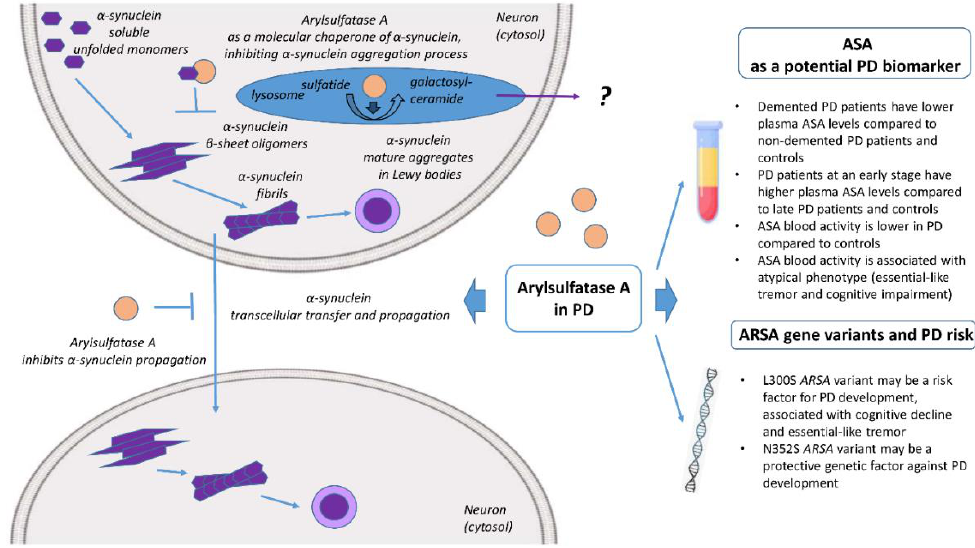
Figure 1. Implication of arylsulfatase A (ASA) in Parkinson’s disease (PD). In vitro and in vivo evidence has demonstrated that ASA may act as a molecular chaperone interacting with α-synuclein (SNCA) in the cytoplasm, thereby preventing its aggregation, secretion, and cell-to-cell propagation. Clinical evidence supports the role of ASA blood levels and activity as a potential biomarker for PD pathology, progression and PD phenotype. ARSA gene variants have been also shown to act as genetic modifiers of PD development.